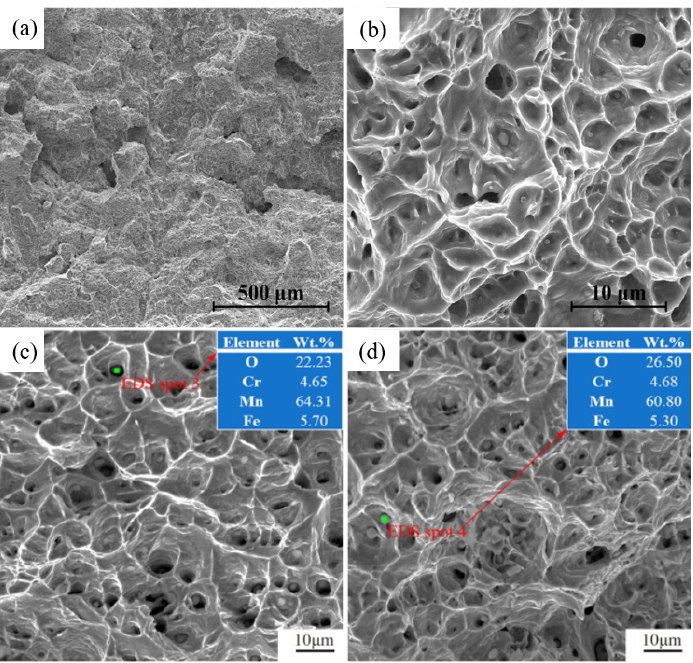
Figure 9. Stretched microscopic fracture morphology. Typical tough fracture morphology in ( a ) and ( b ), Reprinted with permission from ref. [27]. Copyright 2021, Elsevier. Second phase in ( c , d ), Reprinted with permission from ref. [28]. Copyright 2021, Elsevier.